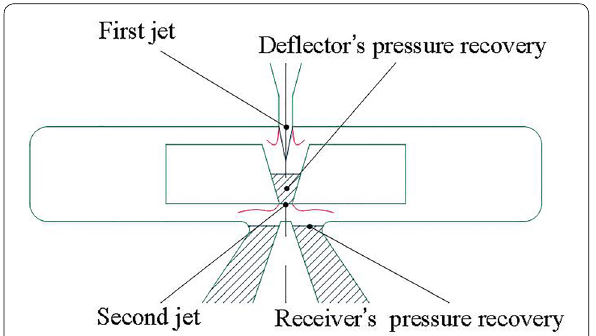
Figure 1 Four stages of the deflector jet